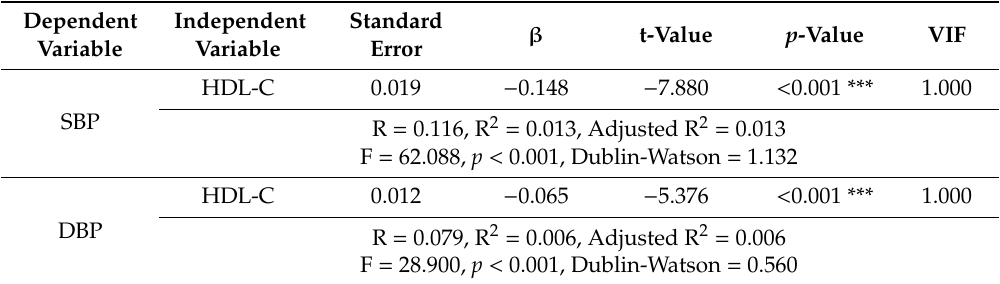
Table 4. Regression analysis between HDL-C and SBP or DBP in total